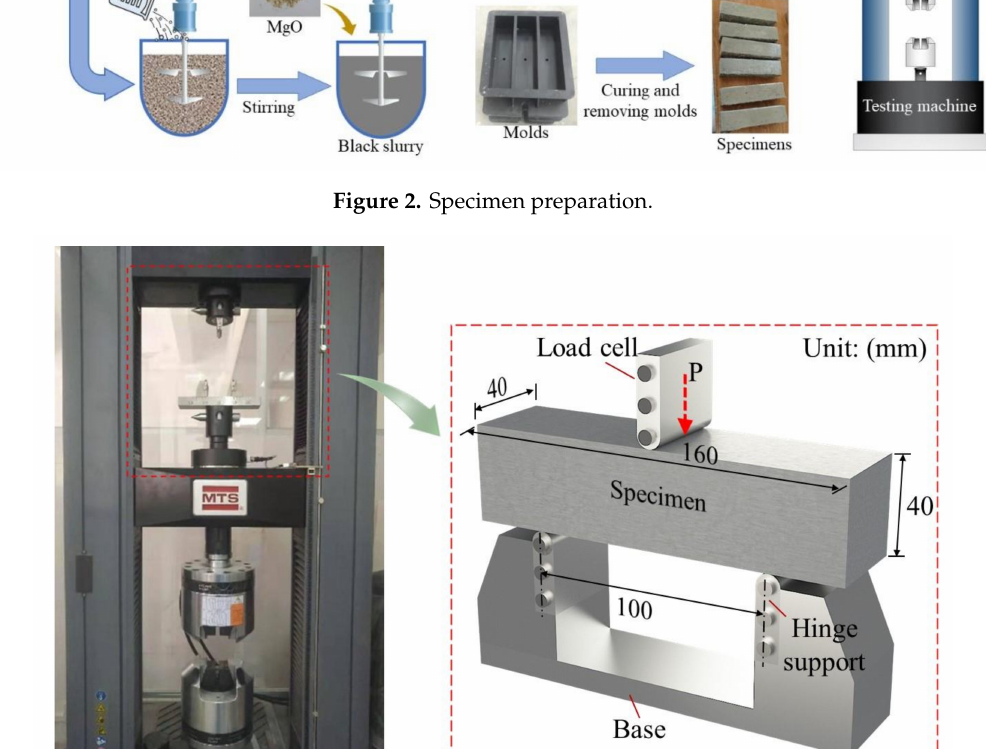
Figure 3. Specimen and test